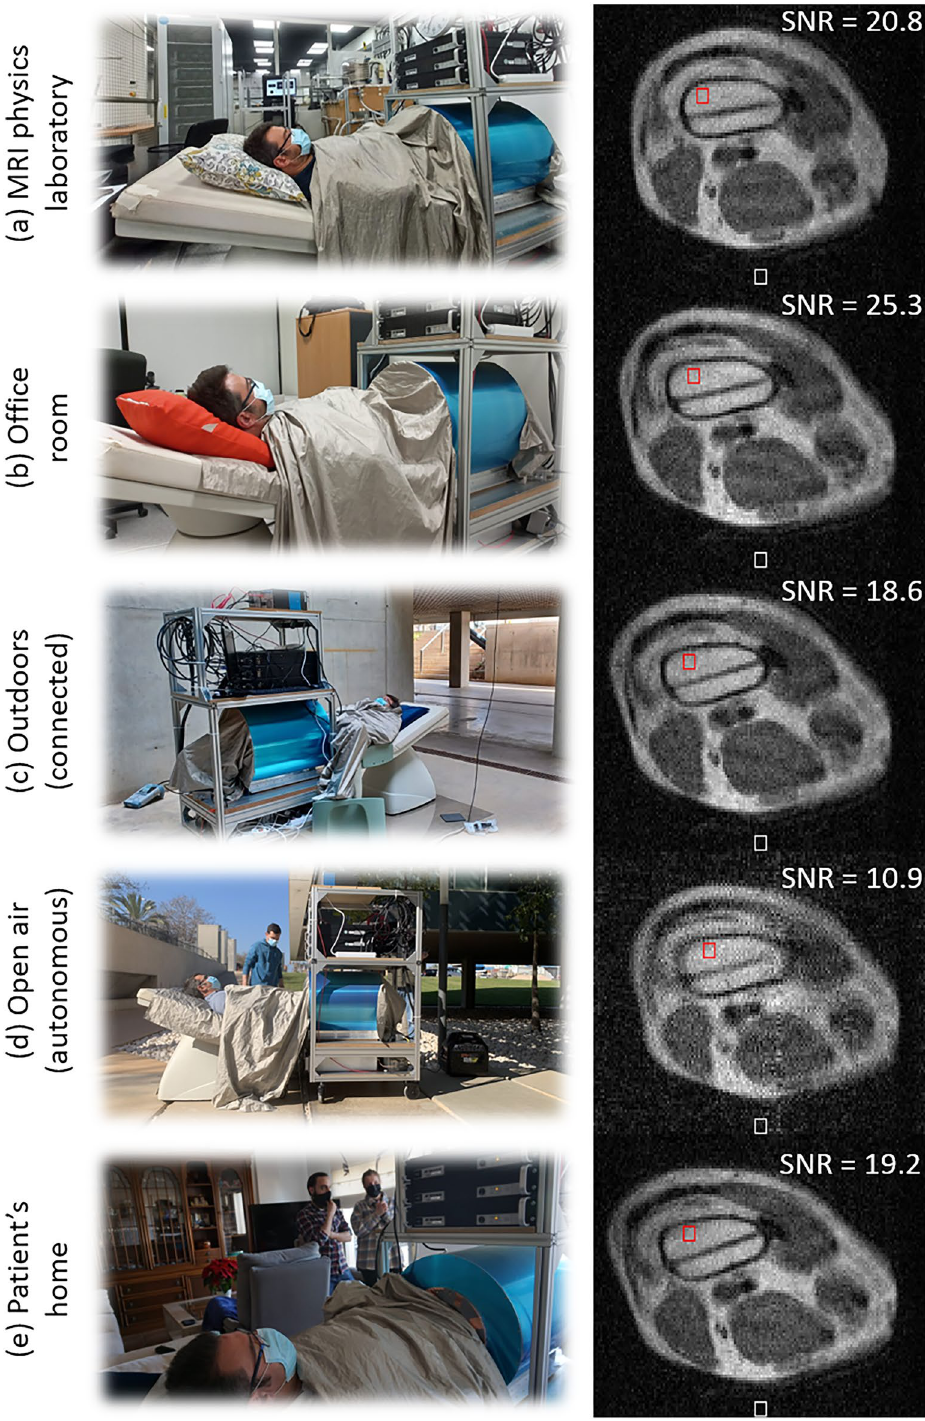
Figure 5. Photographs during acquisitions (left) and axial slice from 3D-RARE reconstructions (right, no post-processing) at five different locations: ( a ) in an MRI physics laboratory; ( b ) in an office room; ( c ) outside a campus building, connected to a nearby power outlet; ( d ) in open air, powered from a small fuel-based generator; and ( e ) at the volunteer’s